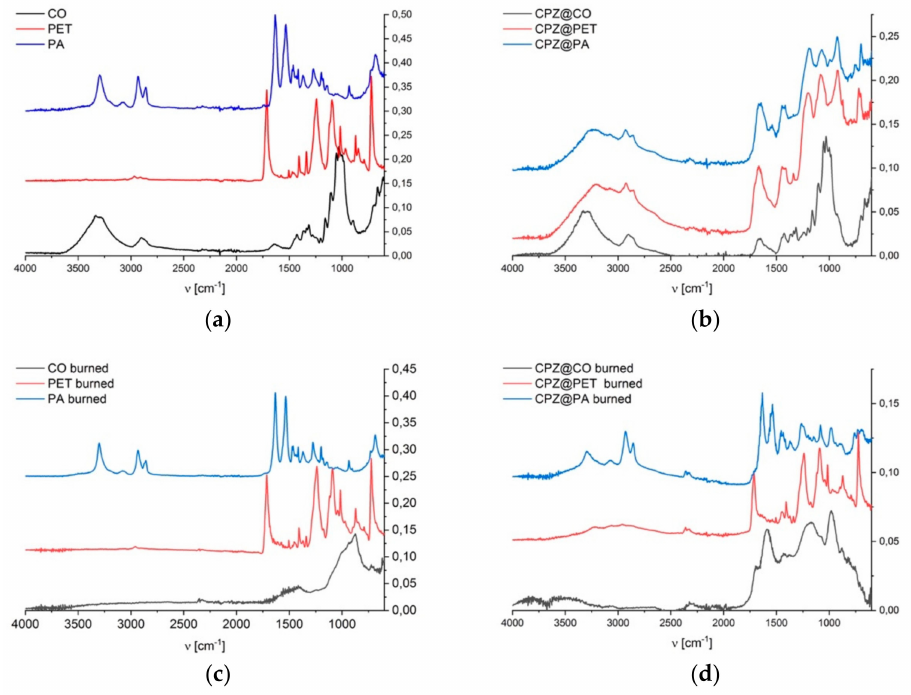
Figure 9. ATR-IR spectra of the pure fabrics after finishing with CPZ and after the flame test, according to DIN EN ISO